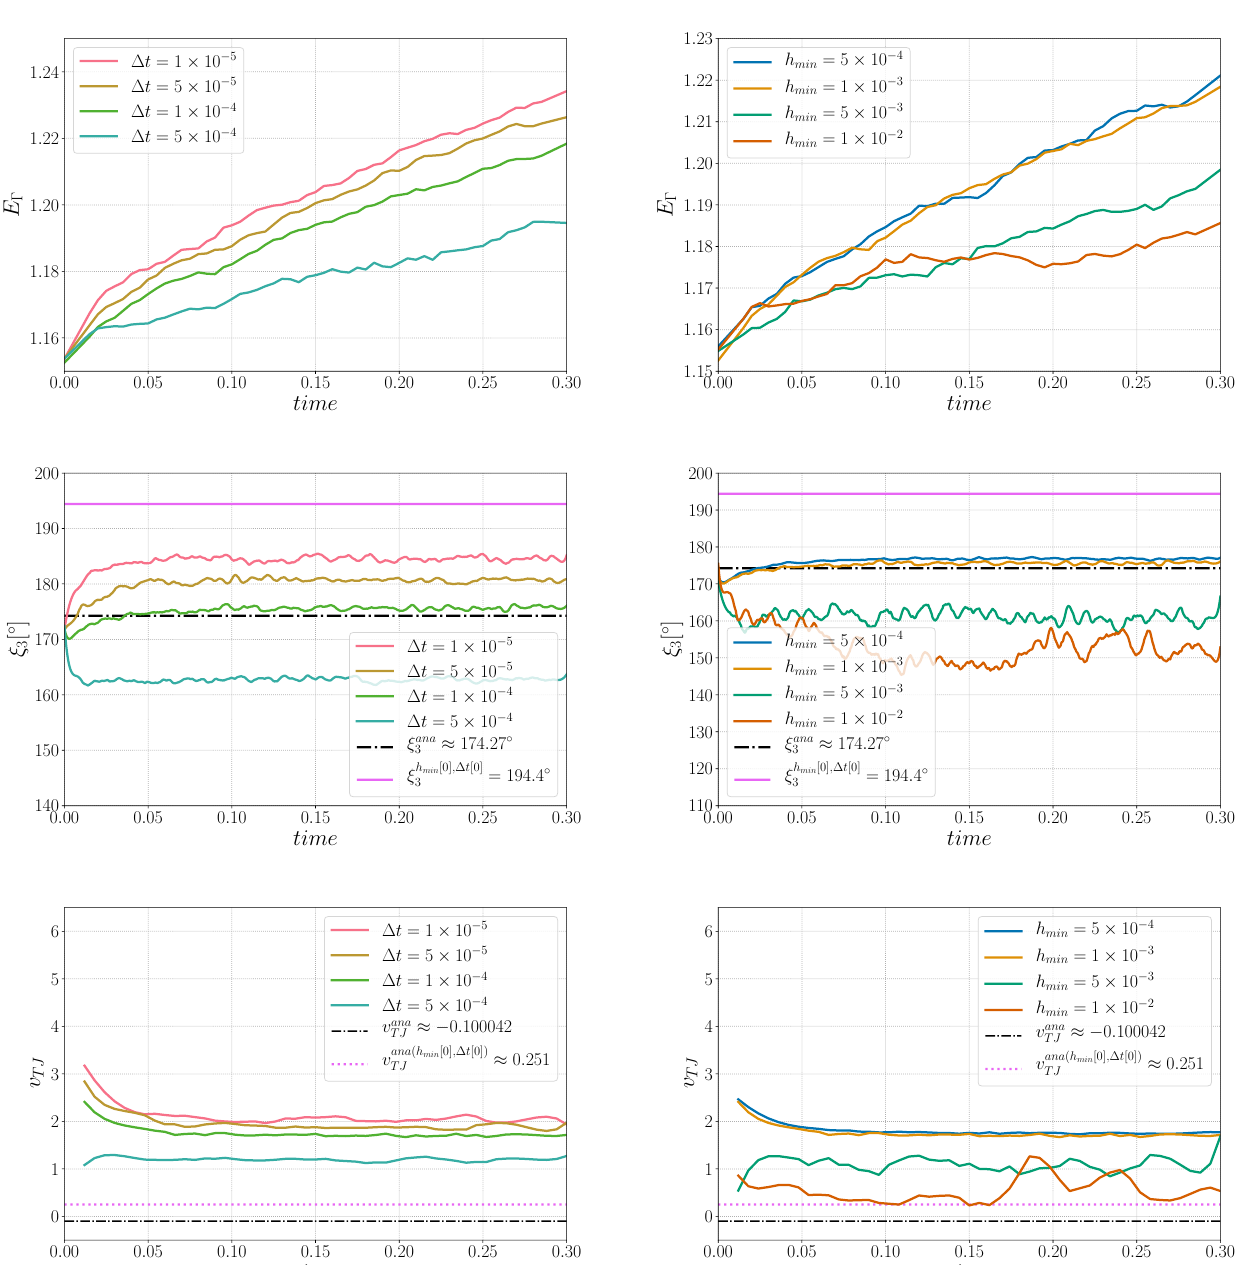
10 − 3 and in ( right ) h min size for ×